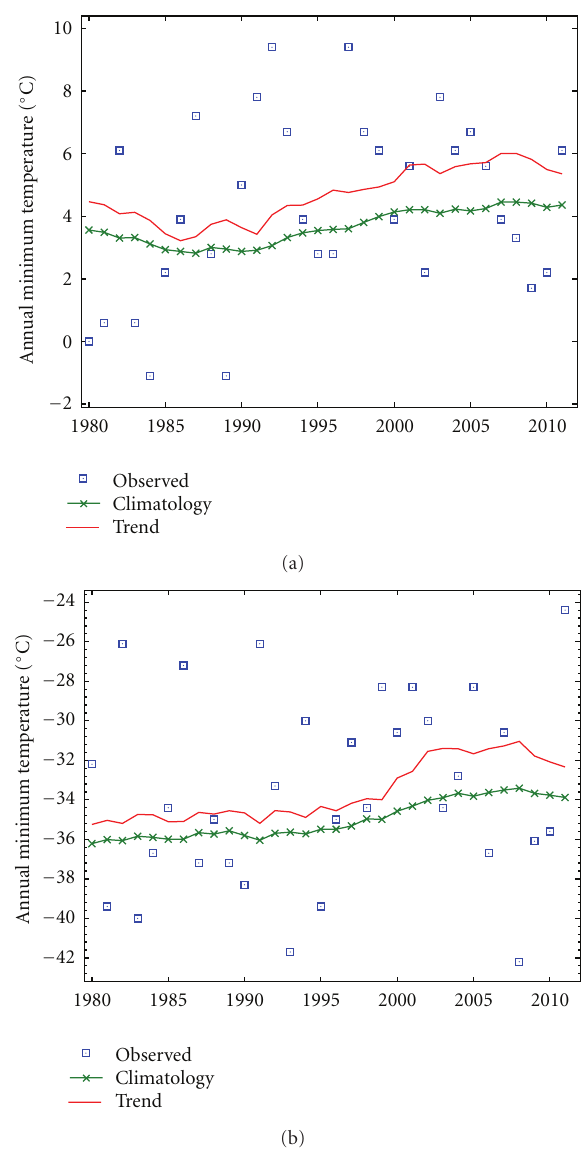
Figure 9: Annual minimum temperatures since 1980 at sample stations, compared to climatology and trend hindcasts (see Sec- tion 2 for details on the hindcast procedures): (a) Miami, Florida (25 . 8 ◦ N, 80 . 3 ◦ W), (b) Bismarck, North Dakota (46 . 8 ◦ N, 100 . 8 ◦ W). Station-specific climatology/trend RMSE, MAE, and bias (K) were (a) 2.89/2.89, 2.42/2.42, − 0.63/+0.40; (b) 4.95/4.85, 4.02/3.99, − 1.48/ − 0.10.